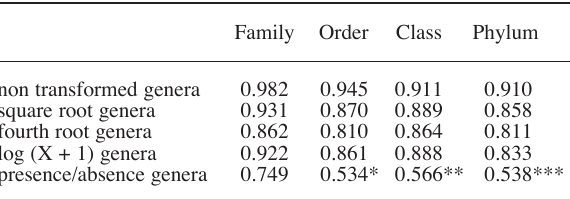
T ABLE 4. – Pair-wise Spearman rank correlations between similari- ty matrices derived from genera abundance data, aggregated to higher taxonomic levels and using different transformations. The majority of correlations are significantly different from zero, by a permutation test, at p < 0.001; exceptions * p < 0.002; ** p < 0.005 and ***p < 0.016. The columns correspond to the taxonomic level and the rows to the transformations